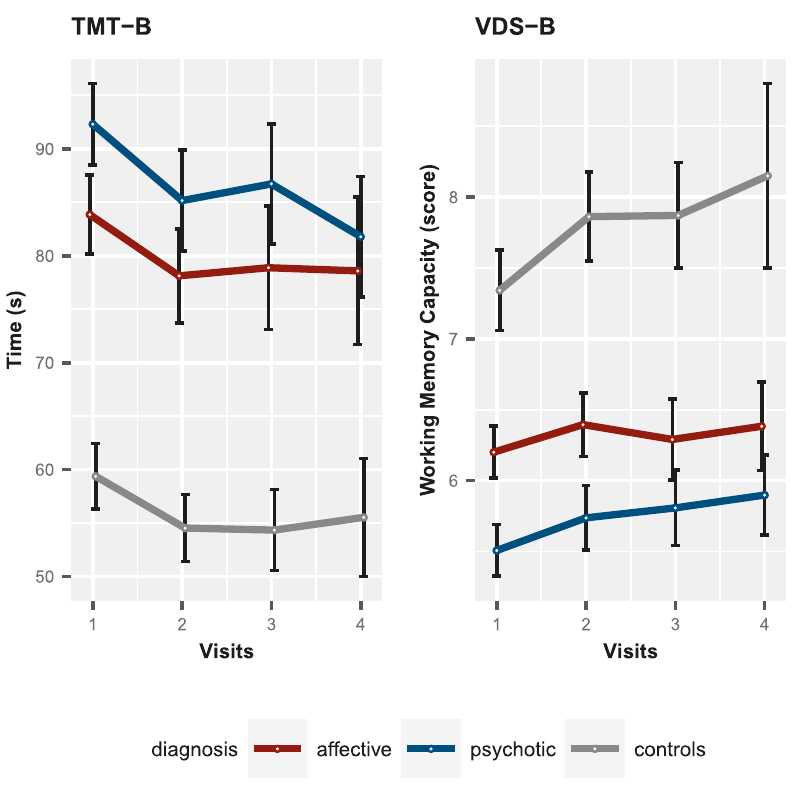
Fig. 1 Longitudinal course of TMT-B score (time in seconds, left) and VDS-B score (working memory capacity, right) for each diagnostic group in the discovery sample. Displayed are means with 95% con fi dence interval for each visit 1, 2, 3, 4, ~6 months apart.